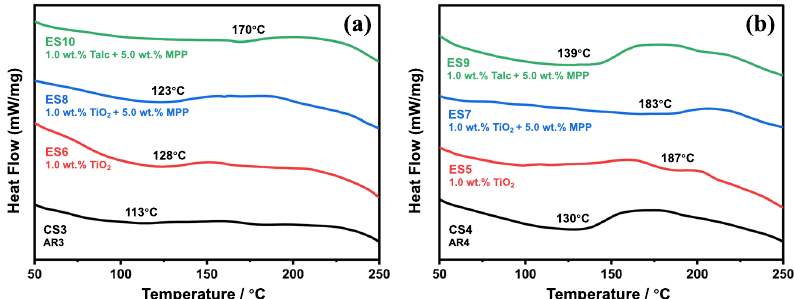
Fig. 3 DSC curves of coating samples a AR3 series with aromatic diamine only and b AR4 series with both aromatic diamine and aromatic diisocyanate.